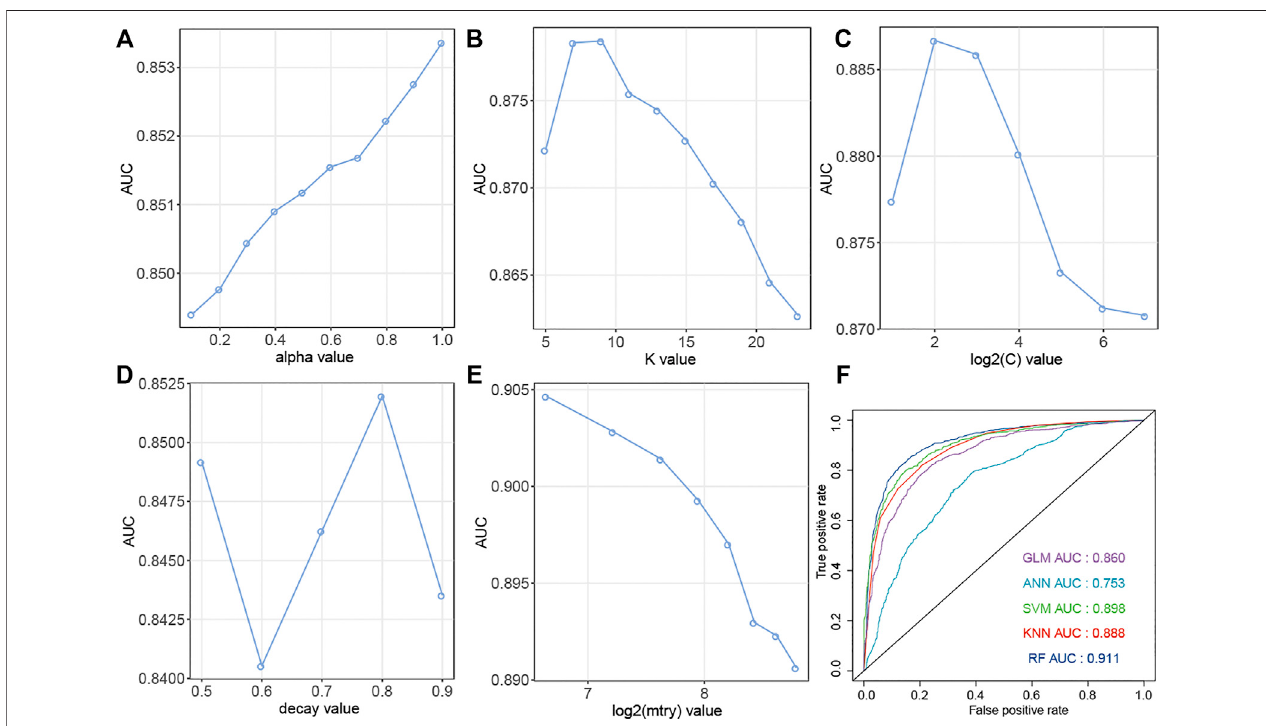
FIGURE 3 | Prediction performance of models for SM-miRNA up-regulation pairs. (A – E) AUC values of 5 machine learning algorithms are generated by the 5-fold crossvalidationonthetrainingdataset. (A) GeneralizedLinearModels(GLM). (B) K-nearestNeighbors(KNN). (C) SupportVectorMachine(SVM). (D) GradientBoosting Machine (GBM). (E) Random Forest (RF). (F) AUC values of 5 models were calculated on the testing dataset.